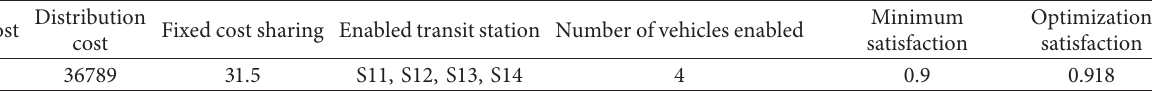
Table 7: Solving optimization